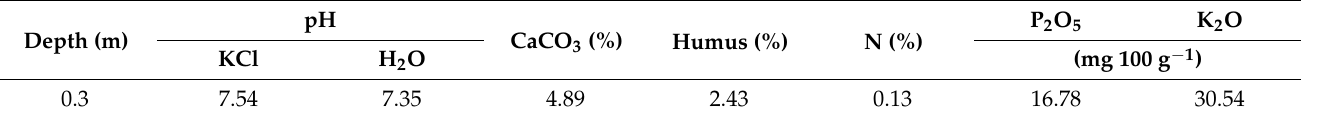
Table 1. Agrochemical analysis of the research area